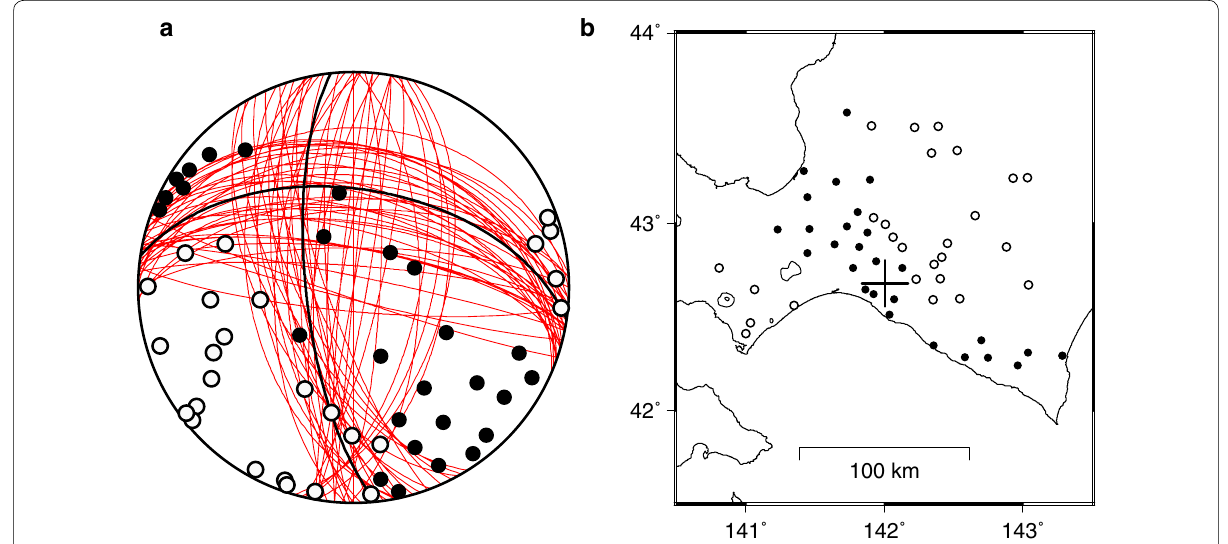
Fig. 4 a Focal mechanism solution of the 2018 Hokkaido Eastern Iburi earthquake. The diagram is an equal area projection on the lower hemisphere of the focal sphere. Solid and open circles indicate compressional and dilatational first motions, respectively. The black lines indicate the preferred nodal planes, whereas the red lines show 50 mechanisms chosen from the set of acceptable solutions. b Geographical distribution of the polarity data. A cross indicates the epicenter of the main shock